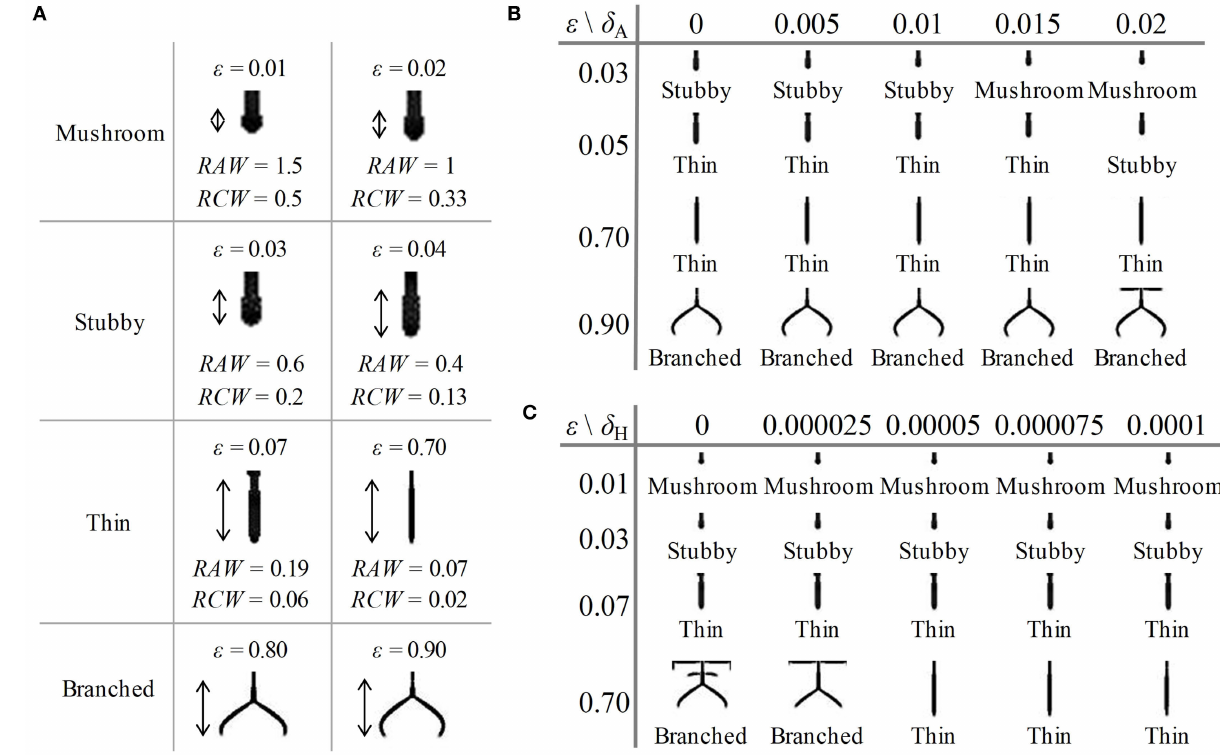
FIGURE 4 | Influence of parameters on the shape of dendritic spines. (A) Some of the results of spine simulations for the condition of δ A = 0.01, δ H = 0.00005, 0.01 ≤ ε ≤ 0.9 (with different amplification factors). Arrows mark the newborn parts of spines growing from the original state in Figure 2C . With the enhancement of neuron activity, the values of RAW and RCW decrease, and all four shapes are obtained. The shape can be mushroom (0 < ε ≤ 0.02), stubby (0.02 < ε ≤ 0.04), thin (0.04 < ε ≤ 0.7) or branched (0.7 < ε ≤ 0.9) types. (B) The results of spine simulation in the condition of δ A = 0, 0.005, 0.01, 0.015, and 0.02, δ H = 0.00005, ε = 0.03, 0.05, 0.7, and 0.9. With the addition of an exogenous activator, the stubby-type spine becomes mushroom-type, and the thin-type spine becomes stubby-type. (C) The results of spine simulation in the condition of δ A = 0.01, δ H = 0, 0.000025, 0.00005, 0.000075, and 0.0001, ε = 0.01, 0.03, 0.07, and 0.7. With the addition of an exogenous inhibitors, the branched-type spine becomes thin-type. In (A–C) , fixed parameters in Equation (2): c = 0.002, µ = 0.16, υ = 0.04, ρ A = 0.01, ρ H = 0.00005, c 0 = 0.02, γ = 0.02, D A = 0.02, D H = 0.26, D S = 0.06, d = 0.0035, e = 0.1, and f =